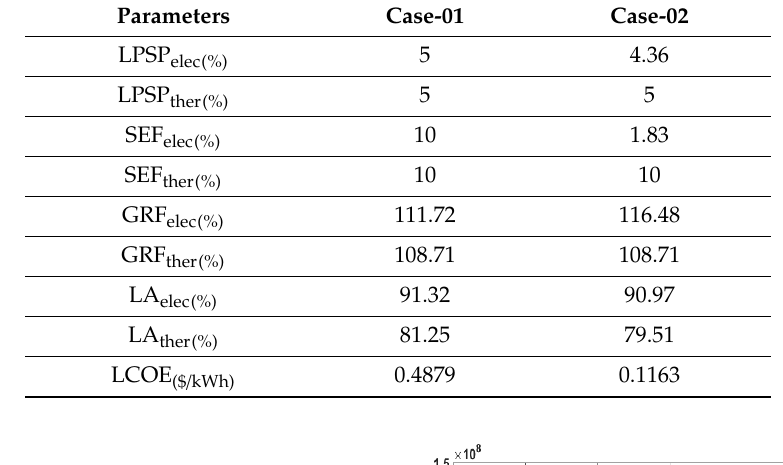
Table 4. Comparison of KPIs.